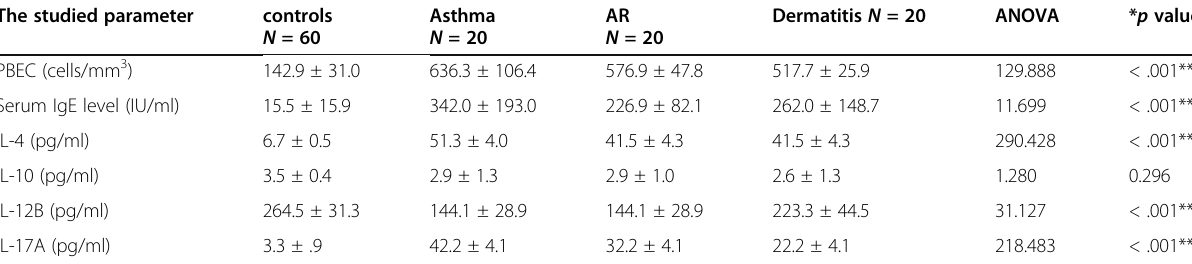
Table 5 Comparison between the studied subgroups regarding laboratory data (IgE levels, eosinophilic count, and interleukins levels)